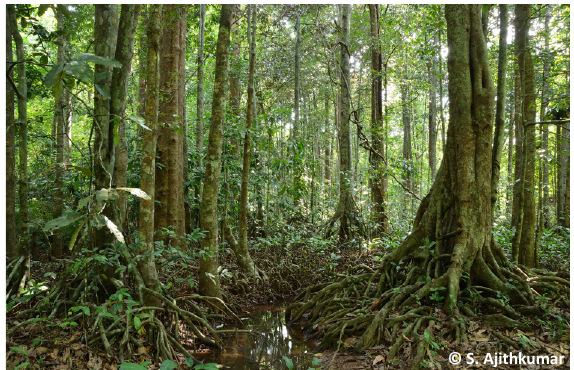
Image 1. Myristica swamp